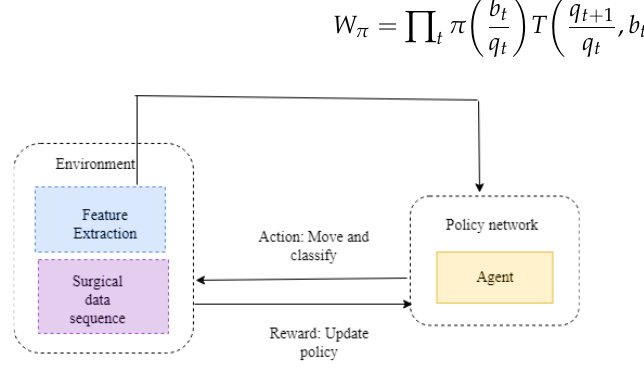
Figure 2. Framework of reinforcement learning.